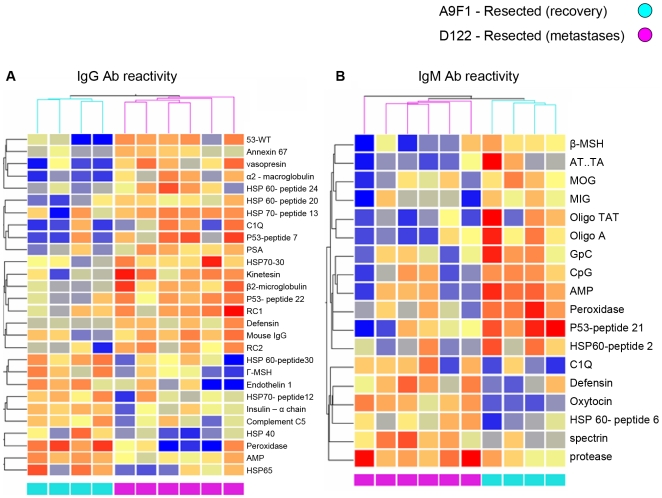
Clustering of antibody reactivities discriminates between mice 17 days following resection of the different clones.Hierarchical clustering of IgG (A) and IgM (B) reactivities for the A9F1 and D122 samples, collected 17 days post-resection, based on their reactivities to separating antigens that were chosen by the Wilcoxon rank-sum test in the array (see supplementary Table S3II, Supplementary Data). A color code denoting A9F1 (light blue) and D122 (pink) samples is shown at the top and bottom. The color scale shows the relative degree of antibody binding from low (dark blue) to high (dark red). The groups are successfully separated both by IgM and IgG reactivities.